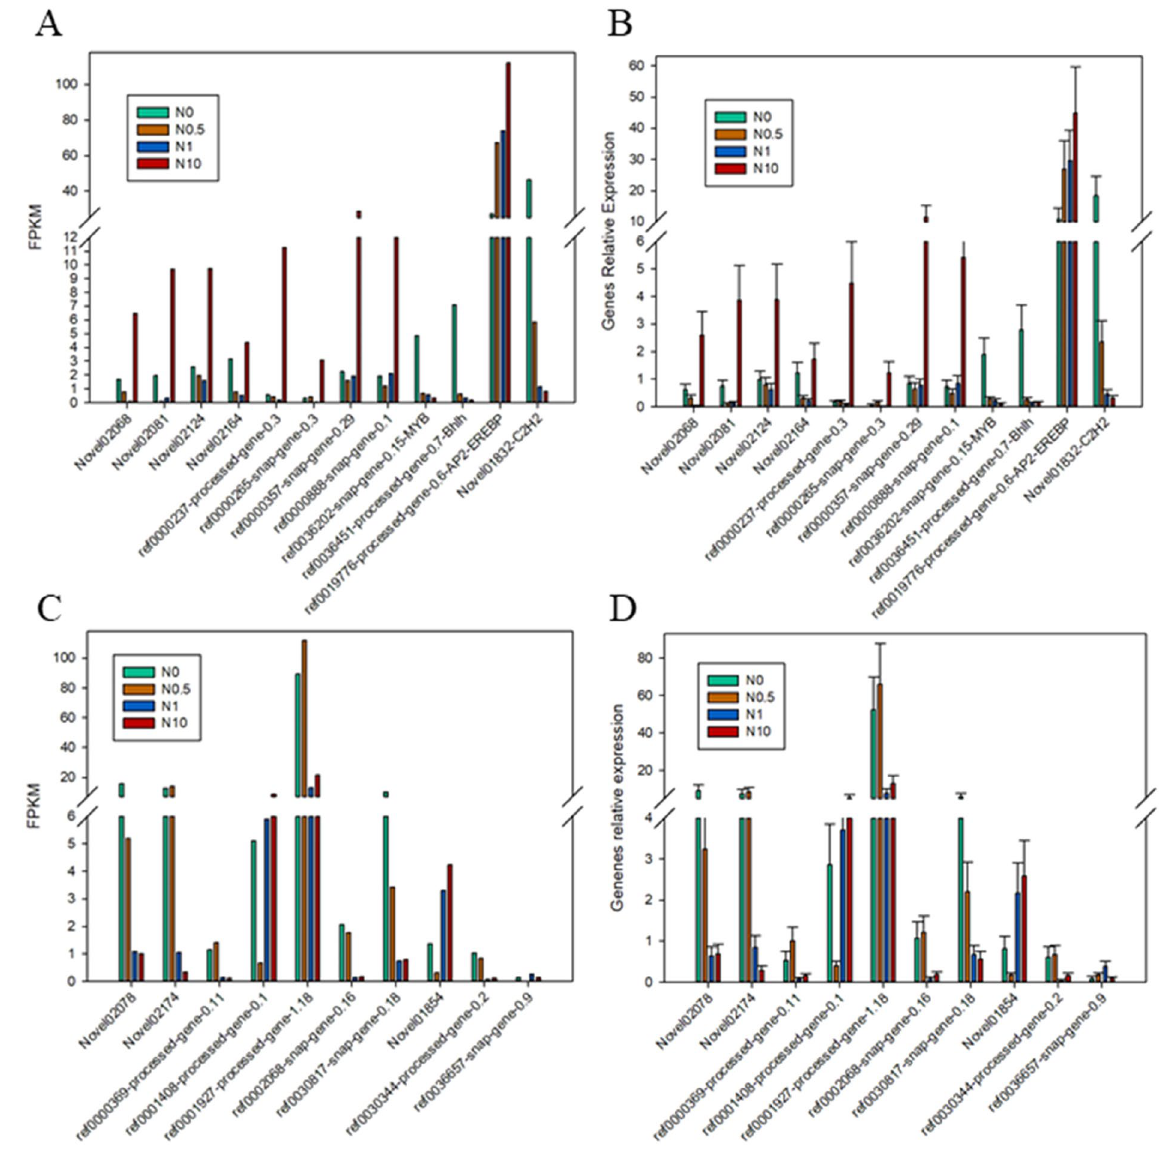
Figure 11. Expression of genes selected for validation. ( A and C ) represent FPKMs of genes related to nitrogen utilization and excessive nitrogen stress, as determined by RNA-Seq. ( B and D ) represent the relative expression of genes related to nitrogen utilization and excessive nitrogen stress, as determined by